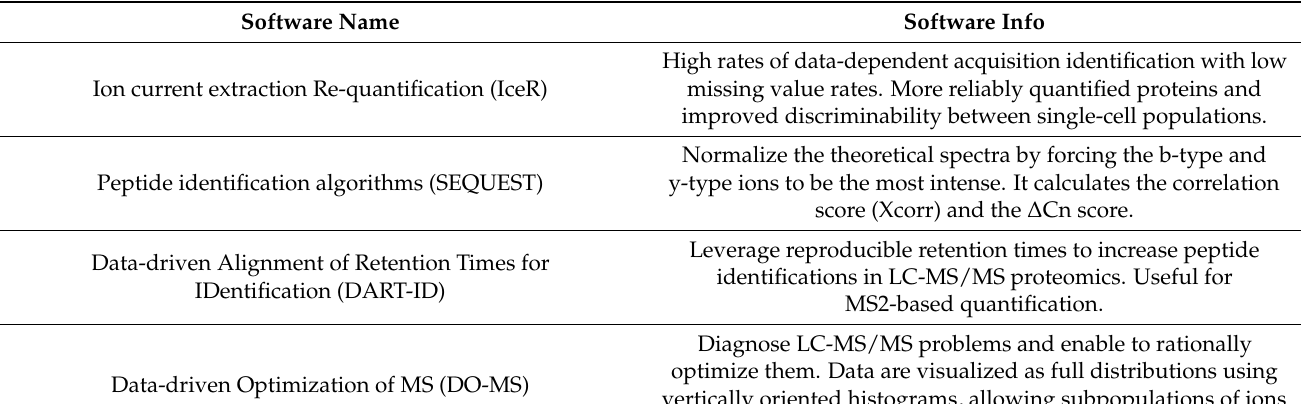
Table 2. Summary of the main computational tools developed in single-cell